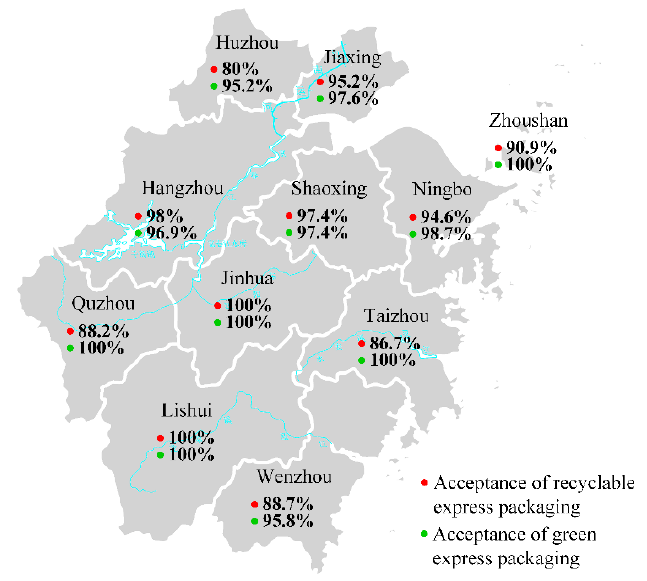
Figure 6. Consumers preferences for environment-friendly packaging in different cities. Table 8. Table of chi-square test results on urban. Fisher’s exact test for city’s recyclable express packaging